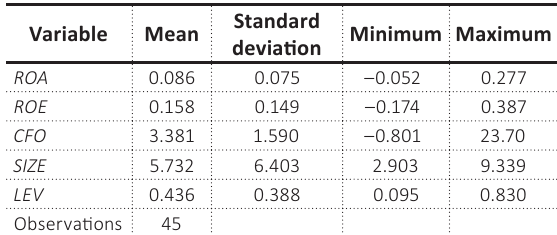
Table 2. Descriptive statistics of study variables